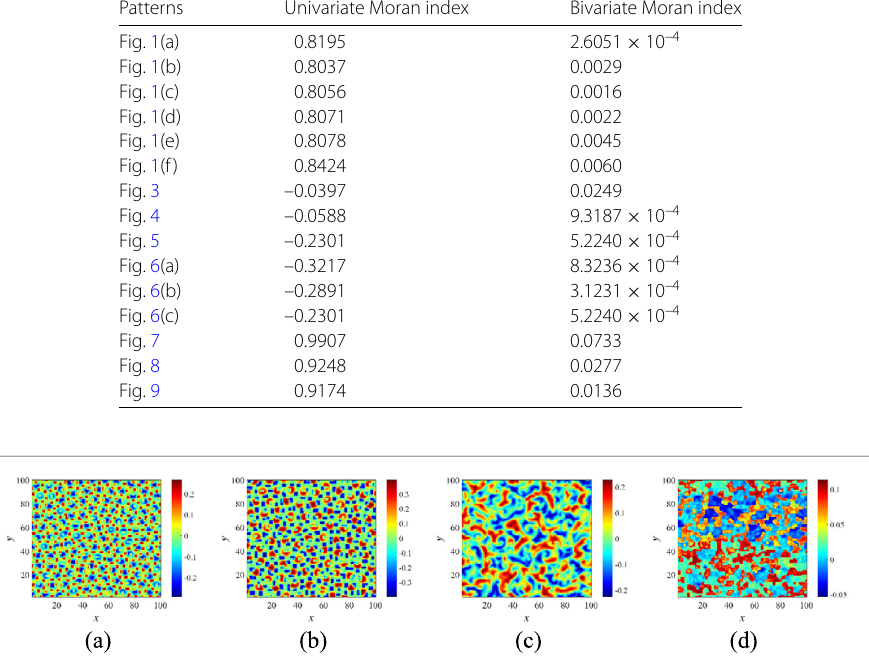
Figure 10 Subtraction between the two patterns which are simulated with the application of Moore and von Neumann neighborhood structures. Same initial conditions and parameter conditions are applied. The